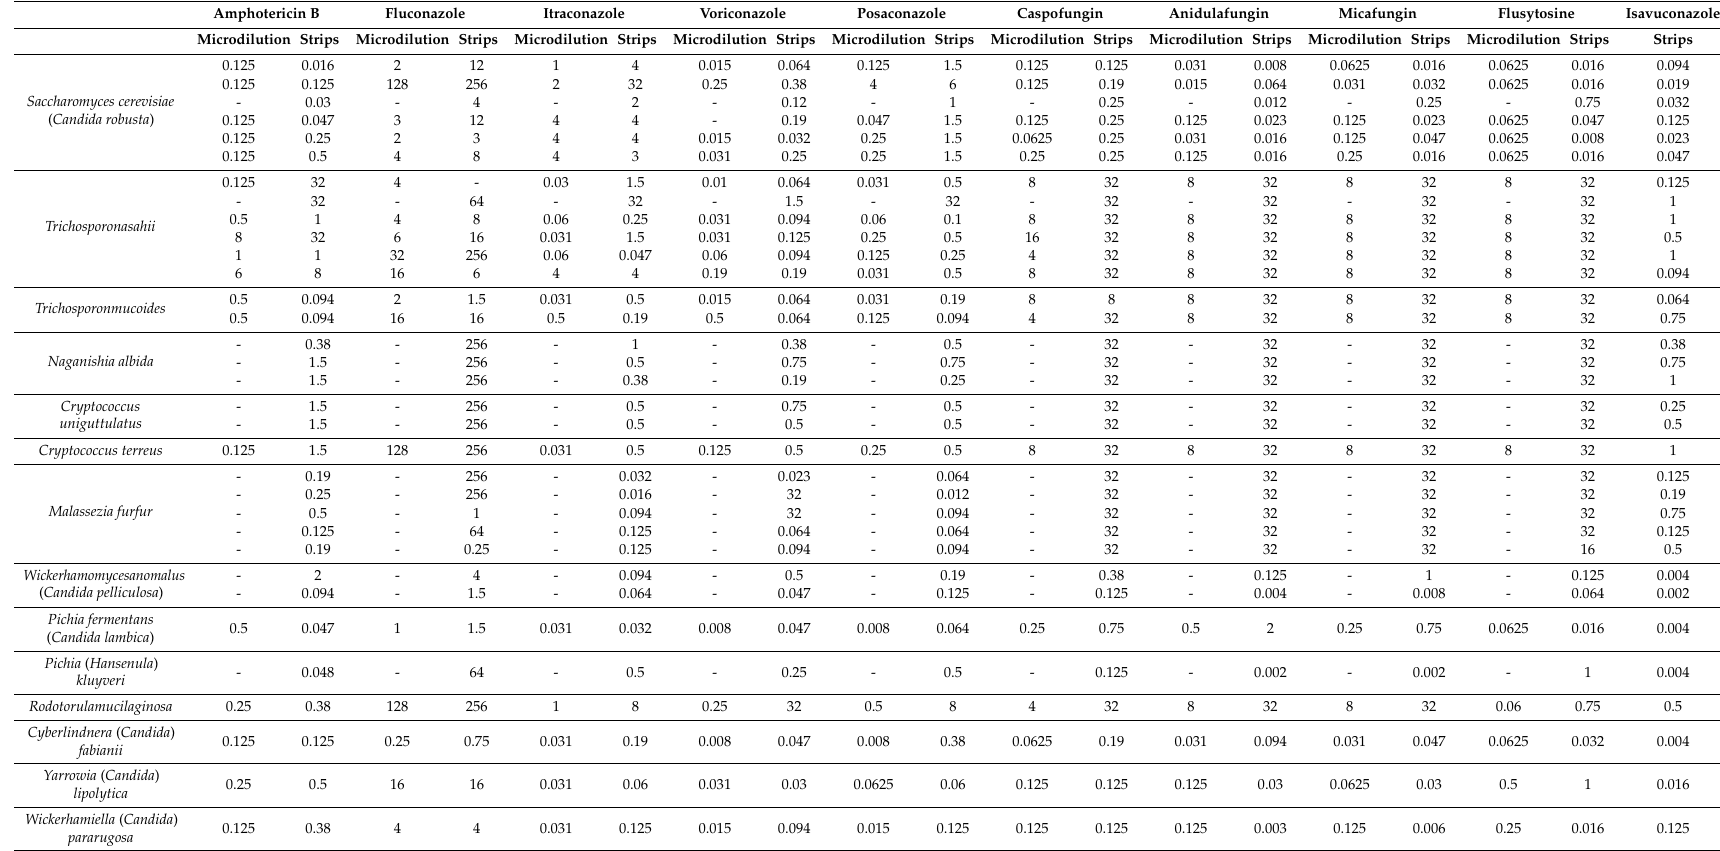
Table 2. Antifungal minimal inhibitory concentrations for isolated